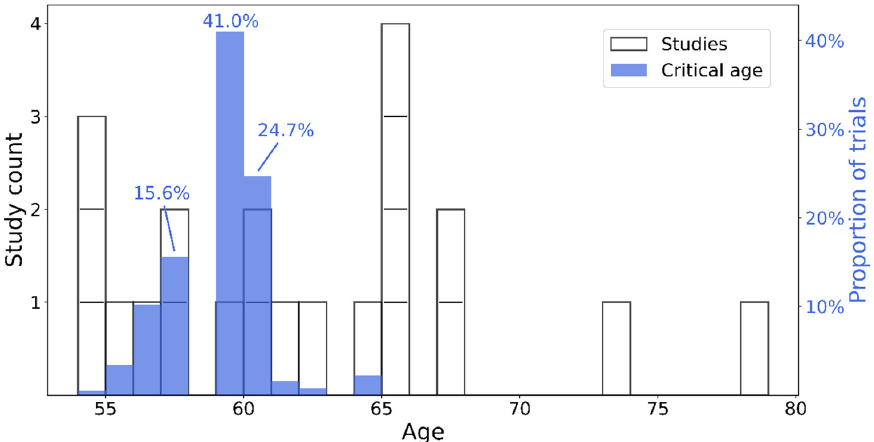
Figure 3. Histogram of age distribution of studies (white–left y axis) and critical age estimation (blue–right y axis). Individual studies are shown as white bar segments. The top three more frequent critical ages, as estimates in the bootstrap process, are highlighted by their respective percentage of positive identification throughout the 1000 trials.